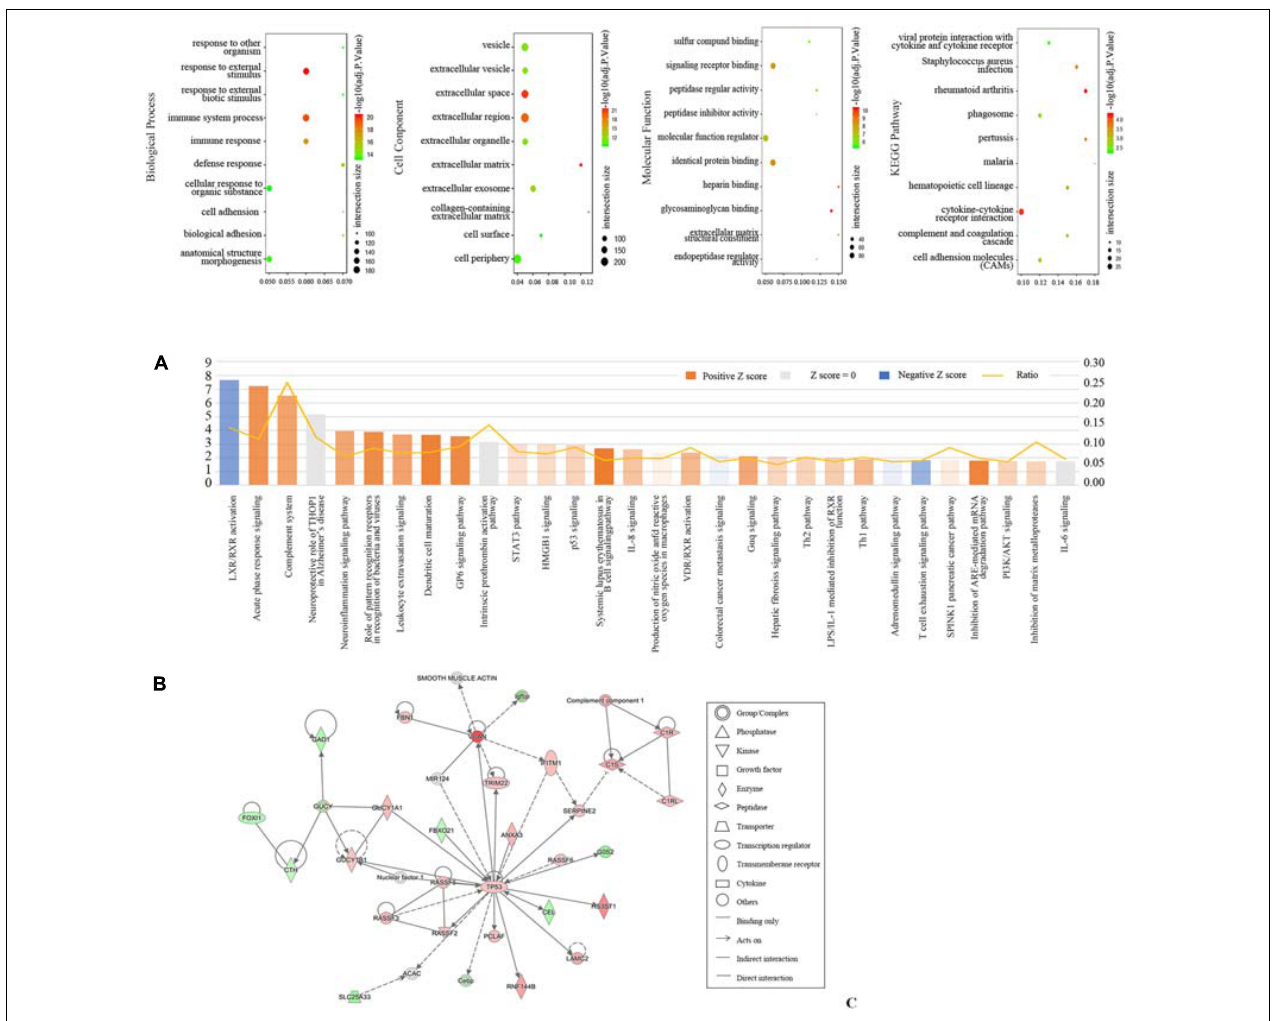
FIGURE 2 | Function profiling of DEGs between seven patients with DKD and seventeen LDs from GSE104954. (A) Bobble plots of GO and KEGG. (B) Top 30 canonical pathways according to IPA. (C) Top 1 network according to